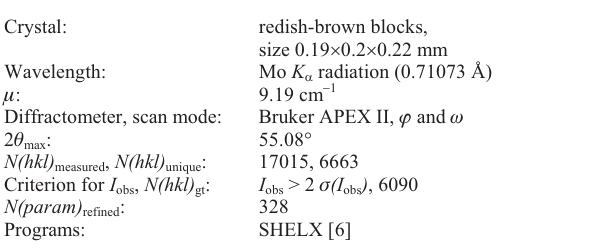
Table 2. Atomic coordinates and displacement parameters (in Å 2 )